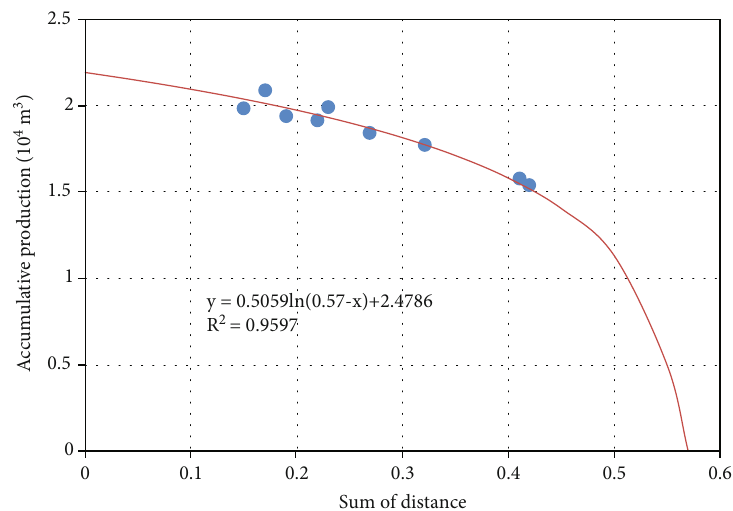
Figure 3: The relationship between distance sum and cumulative production.